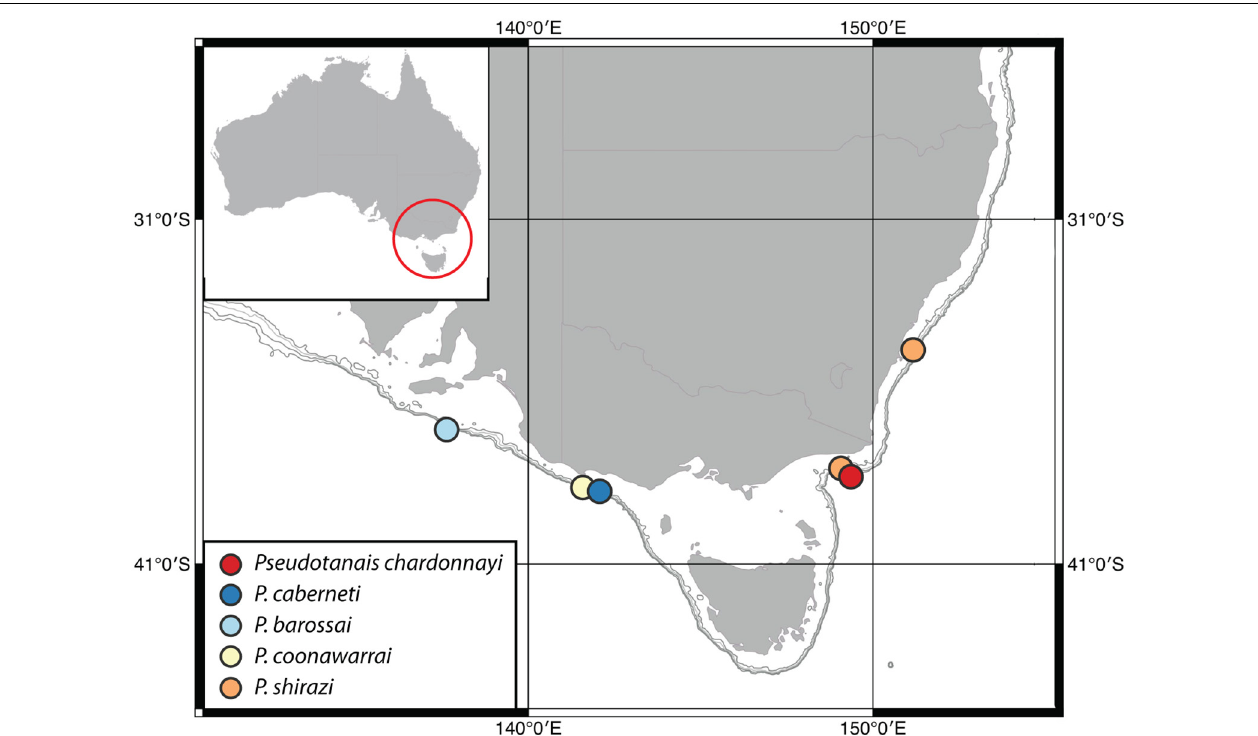
FIGURE 12 | Distribution of Pseudotanaidae (described in this study) on the coast of SE Australia.